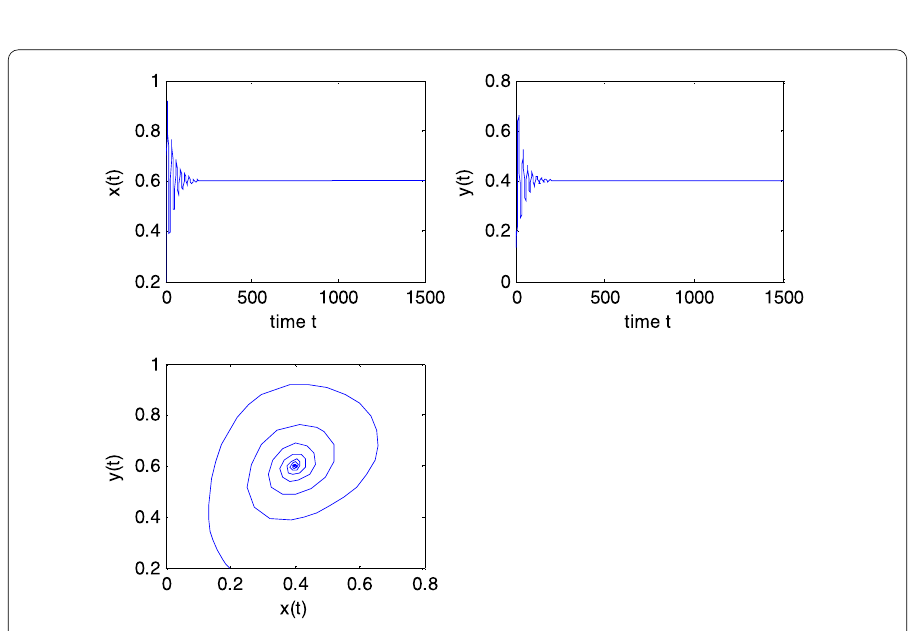
Figure 3 Behavior and phase portrait of a controlled system (1.3) with τ 1 = 0, τ 2 = 3.7 > τ 0 bifurcation disappears.